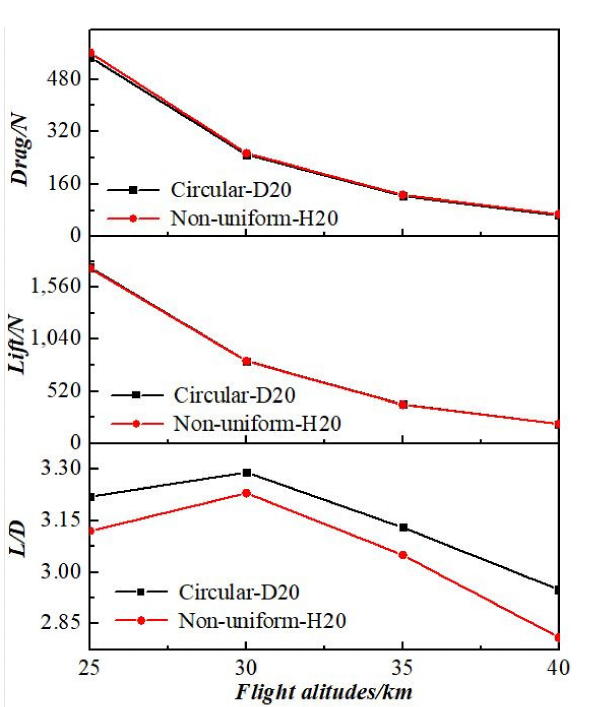
Figure 18. Aerodynamic performance of different blunt profiles with various flight altitudes (diame- ter/height: 20